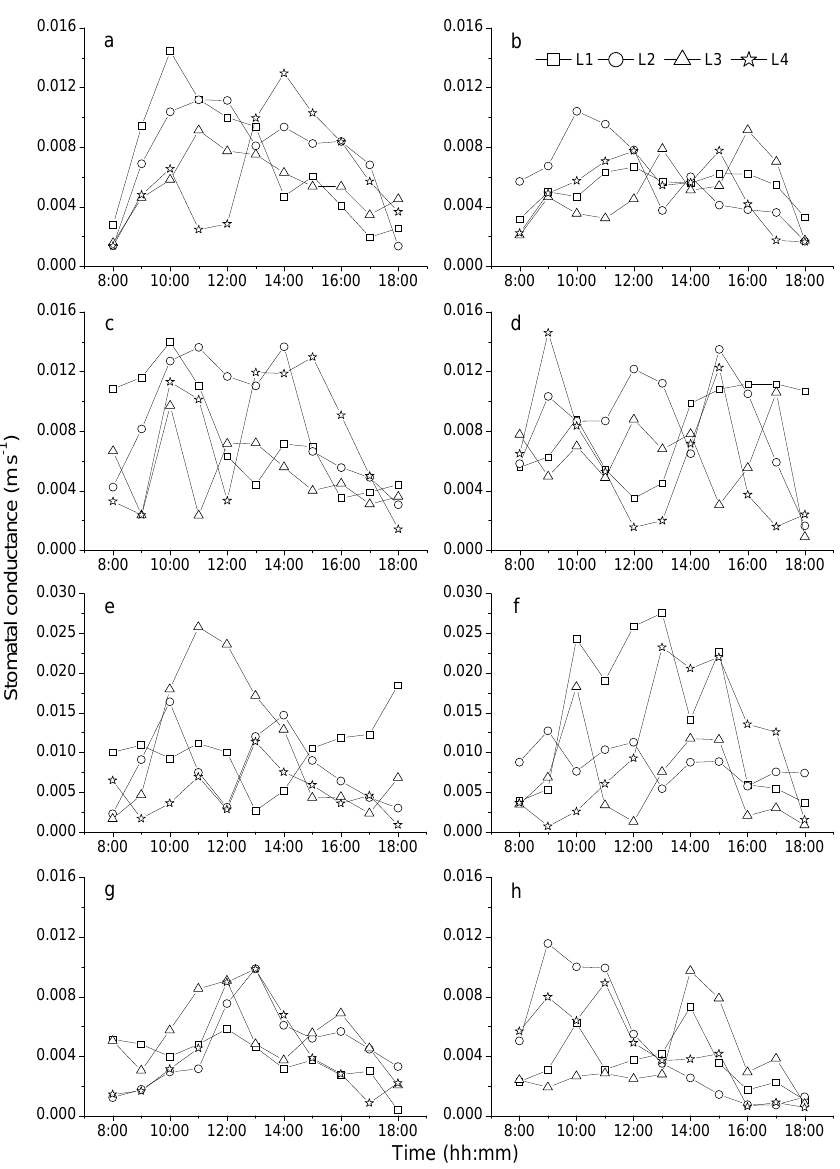
Fig. 1. Diurnal variation in stomatal conductance in the maize canopy. The days are DOY 130 (a) , (b) , DOY 162 (c) , (d) , DOY 195 (e) , (f) and DOY 229 (g) , (h) . L1, L2, L3 and L4 refer to the levels at the top layer, above middle layer, below middle layer and bottom layer of the canopy. a, c, e and g of the left column have the leaf orientation east-west, and b, d, f, and h of the right column have the leaf orientation